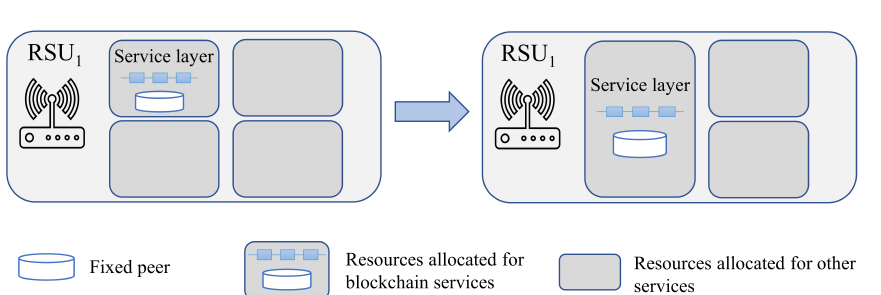
Figure 4. Scaling up locally with the proposed scaling control algorithm.